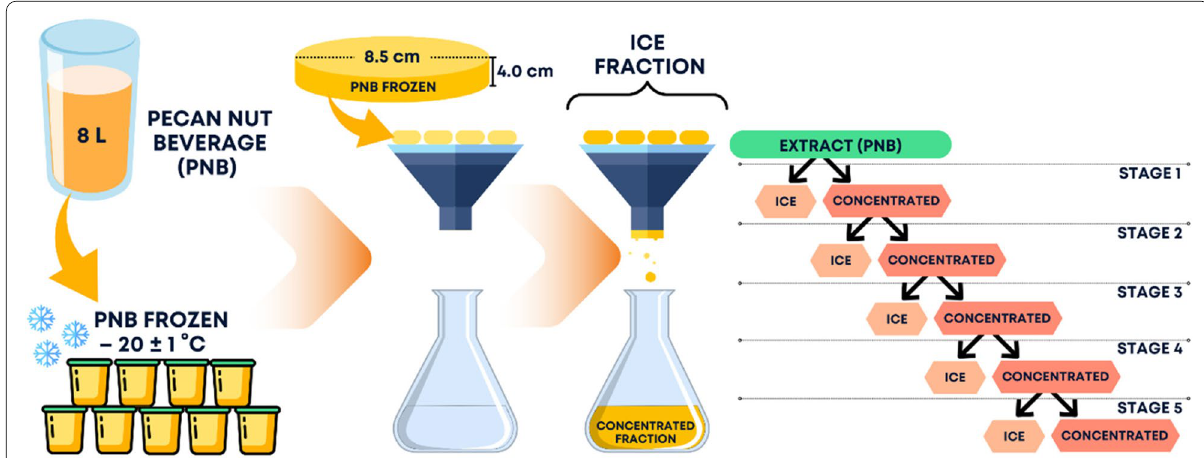
Fig. 1 Schematic diagram of the multi-stage gravitational block freeze concentration process of pecan nut cake